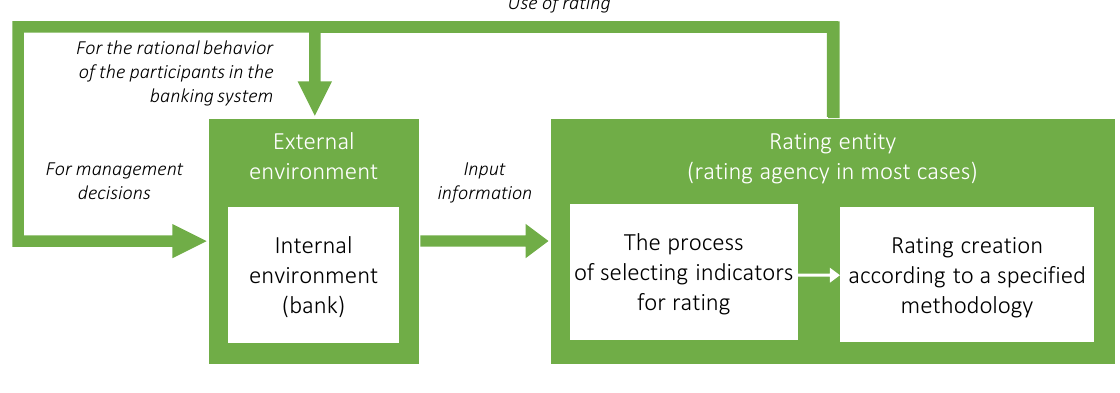
Figure 1. General rating scheme of commercial